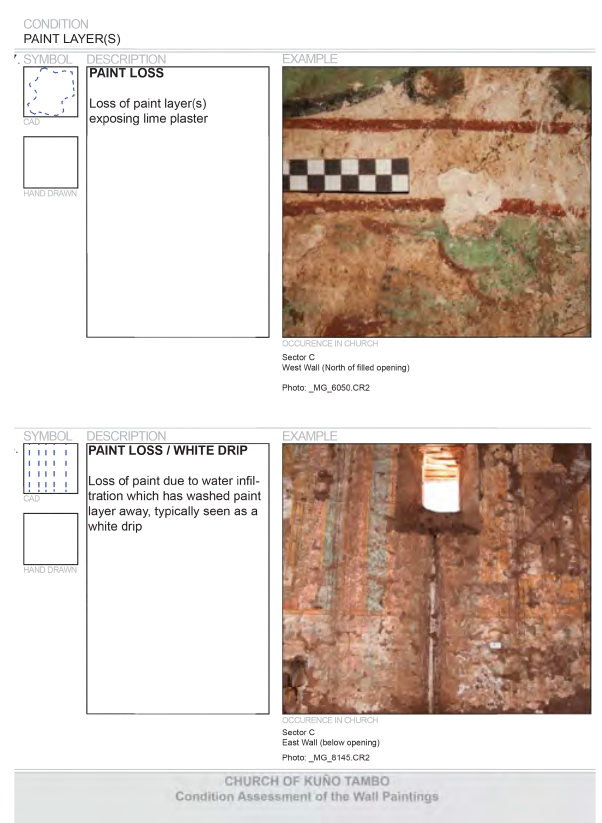
Figure 7. Example of the condition assessment